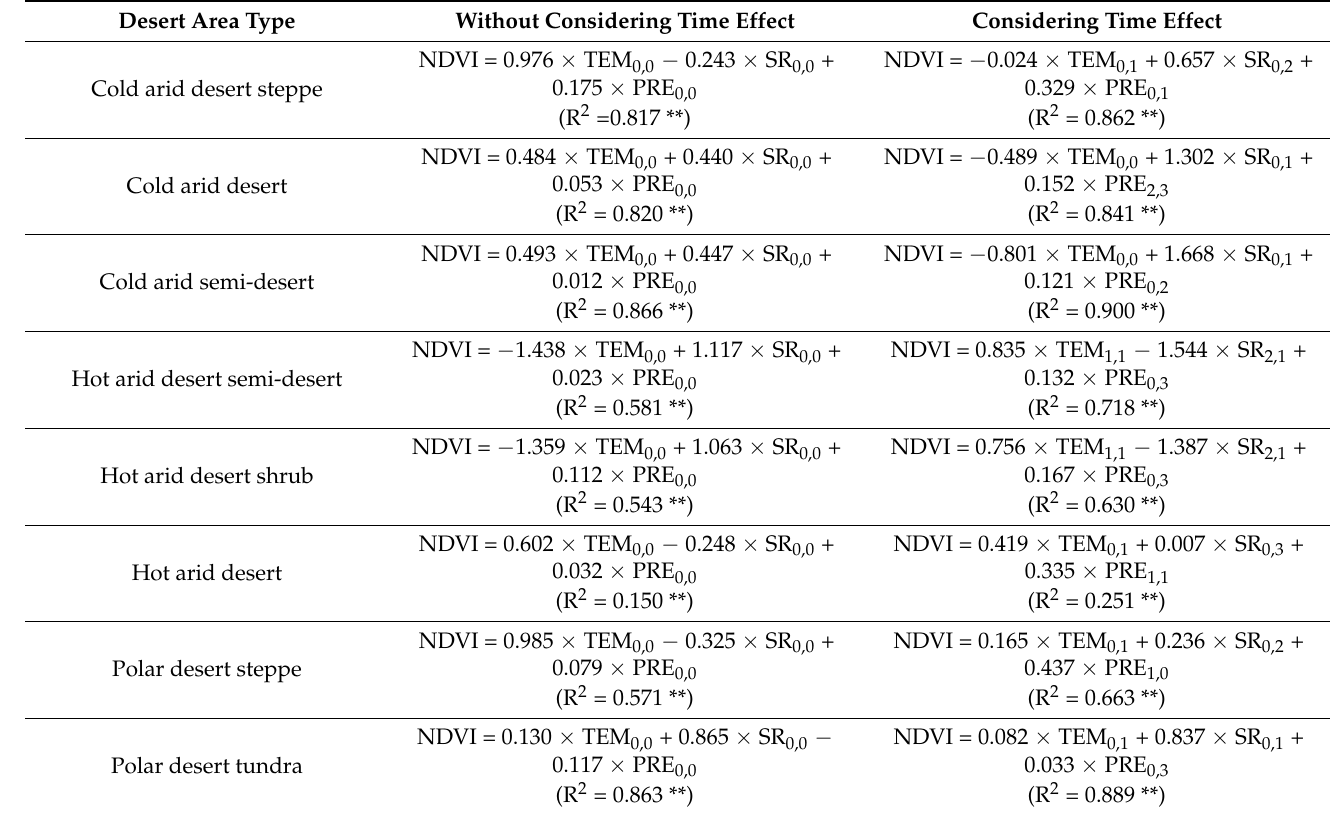
Table 2. Multiple linear regression models between the NDVI and all climatic factors in different desert areas without considering and considering the time effect. TEM i,j , SR i,j , and PRE i,j are air temperature, surface solar radiation, and precipitation with i month lag and j month accumulation effect, respectively. ** indicate statistical significance at p < 0.05. Desert Area